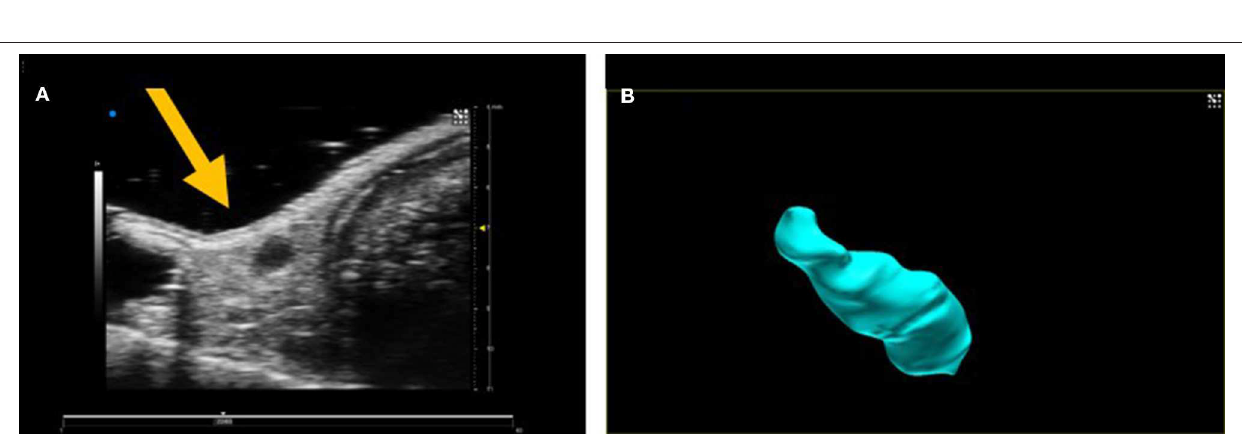
FIGURE 3 | (A) 2D B-mode image of an inguinal lymph node and (B) 3D volume of lymph node after 3D acquisition.